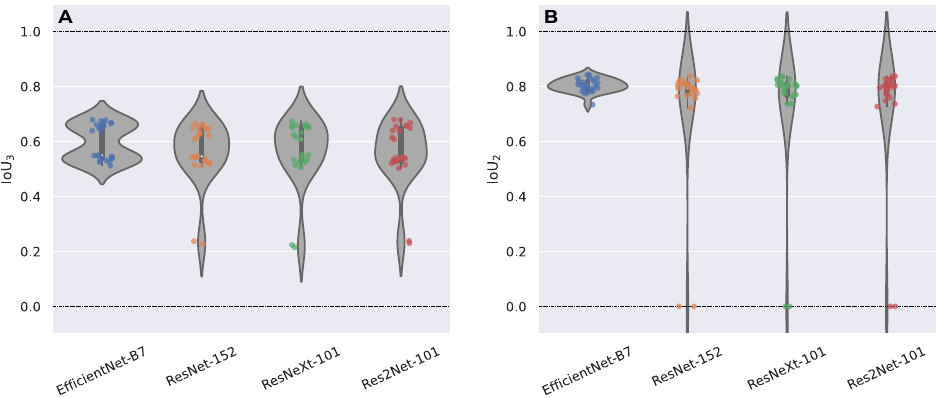
Figure 1. Prediction scores for the validation data; each dot represents performance for k th model of the 25-fold cross-validation; 4 encoders were considered: EfficientNet-B7, ResNeXt-101, ResNet- 152, and Res2Net-101. ( A ) Performance by IoU 3 metric. The Wilcoxon signed-rank test: median performance of Unet with EfficientNet-B7 was greater than for the model with ResNeXt-101, ResNet- 152, and Res2Net-101 with a confidence level of 0.95. ( B ) Performance by IoU 2 metric. The Wilcoxon signed-rank test: the median performance of Unet with EfficientNet-B7 was greater than for the model with Res2Net-101, ResNet-152 with a confidence level of